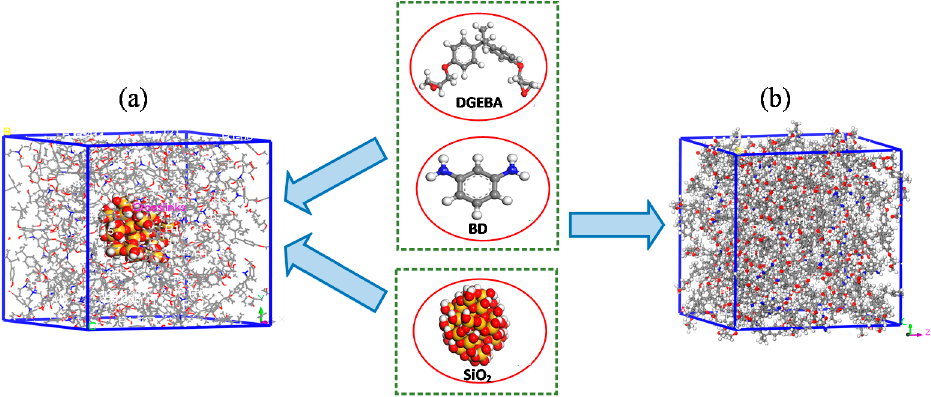
Figure 1. ( a ) SiO 2 composite model; ( b ) pure epoxy resin model.